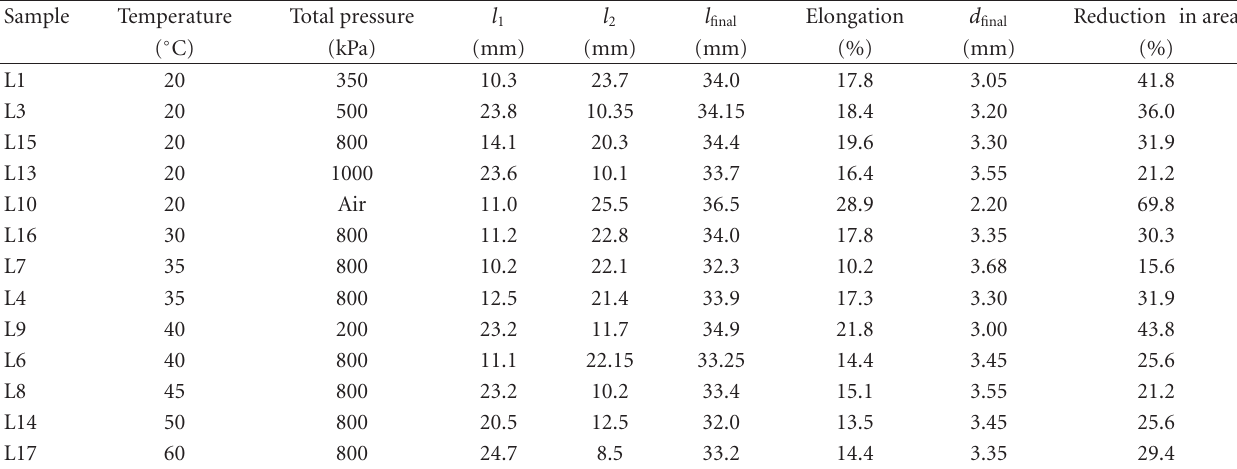
Table 2: Temperature-dependent results of samples machined parallel to the rolling direction. Sample